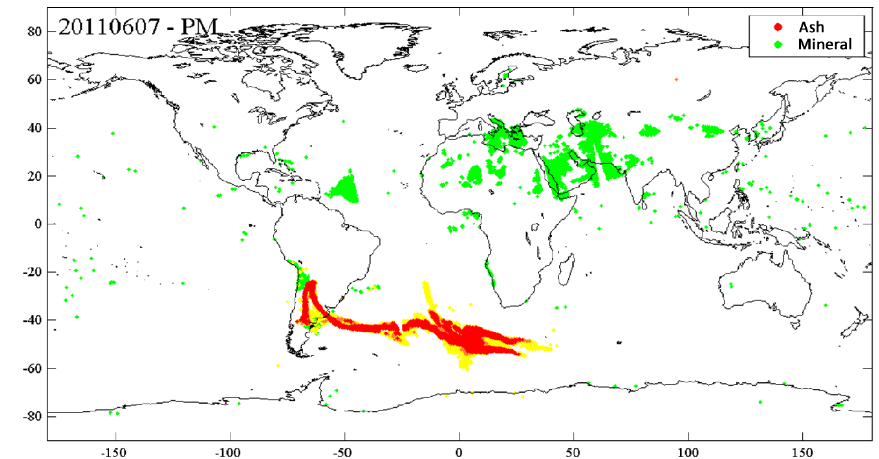
Figure 8. IASI-A detection of volcanic ash (Puyehue–Cordón Caulle eruption) and mineral dust (windblown desert sands) on 7 June 2011 (afternoon). Please note that the date format in this figure is yyyymmdd.